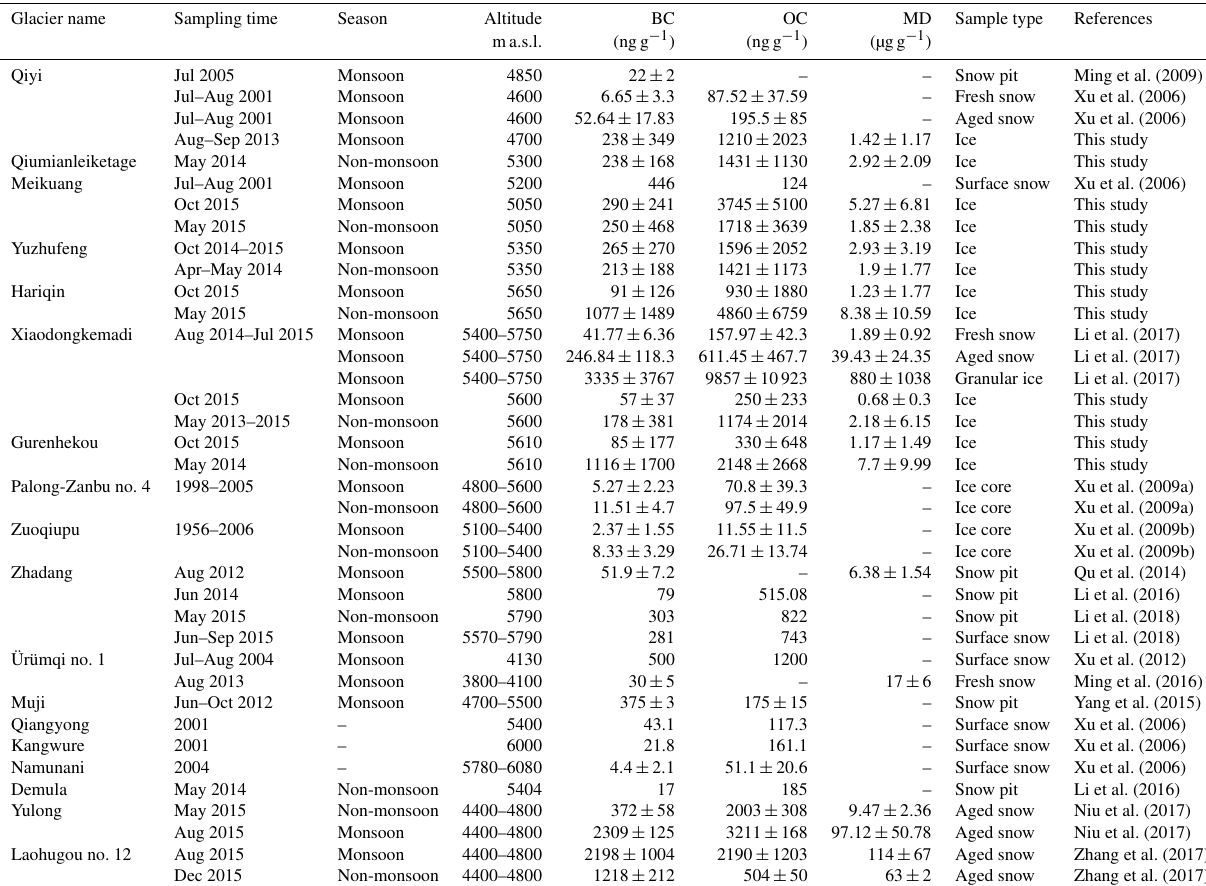
Table 2. Statistics of the ILAPs in snow and ice in the studied TP glaciers and other related glaciers. Glacier